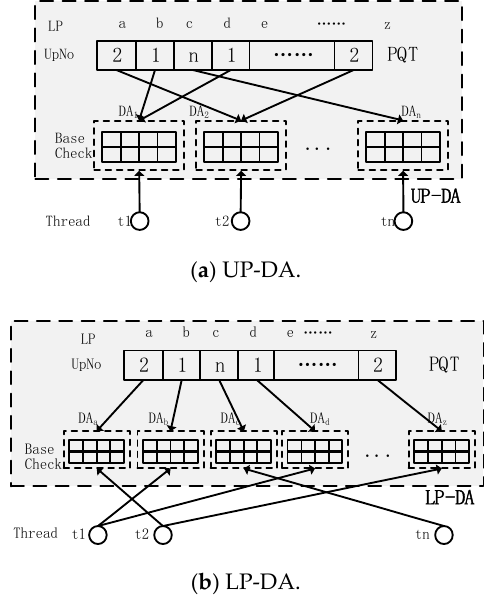
Figure 7. UP-DA and LP-DA.